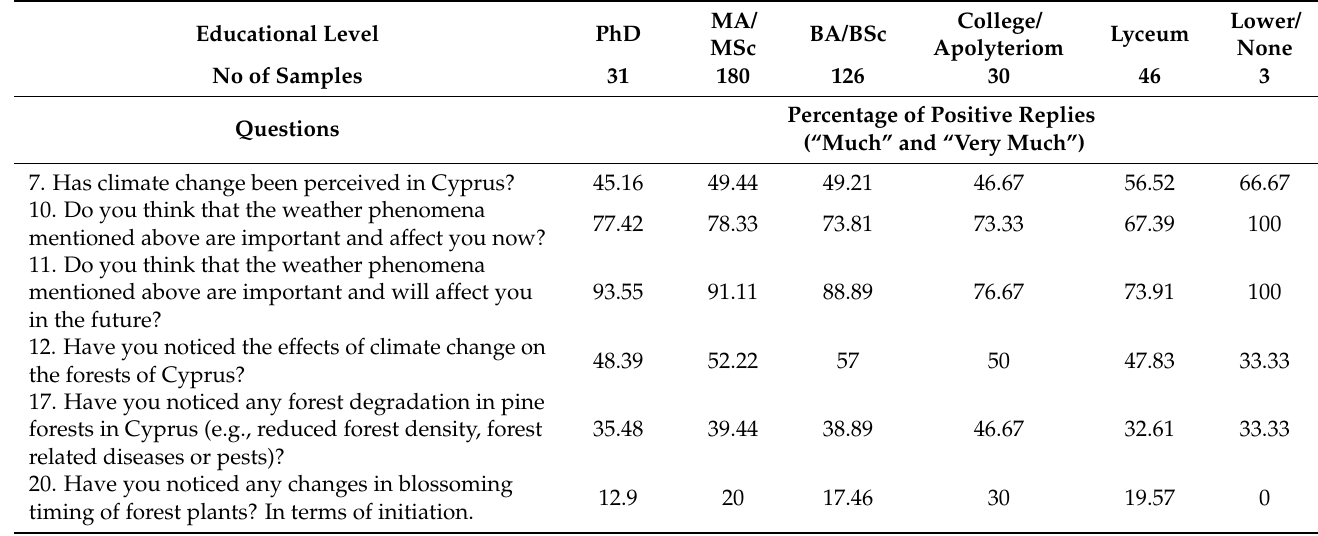
Table 6. Percentage of positive (“Much” and “Very Much”) replies of the Likert Questions according to the educational level of the